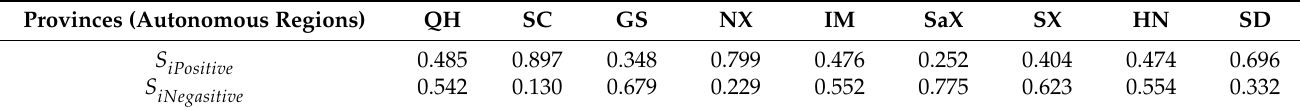
Table A4. The Manhattan Distance between each province (autonomous region) and the ideal